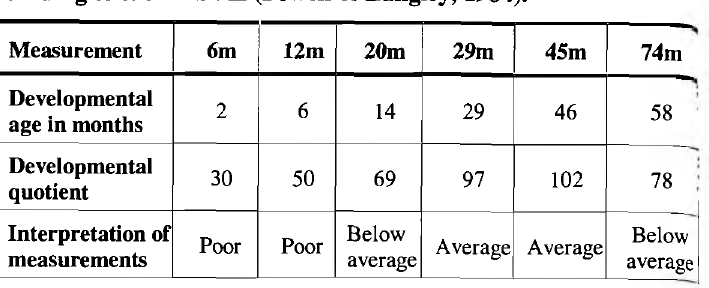
Table 9. The participant’s general developmental progress ac­ cording to the DASI-II (Fewell & Langley,